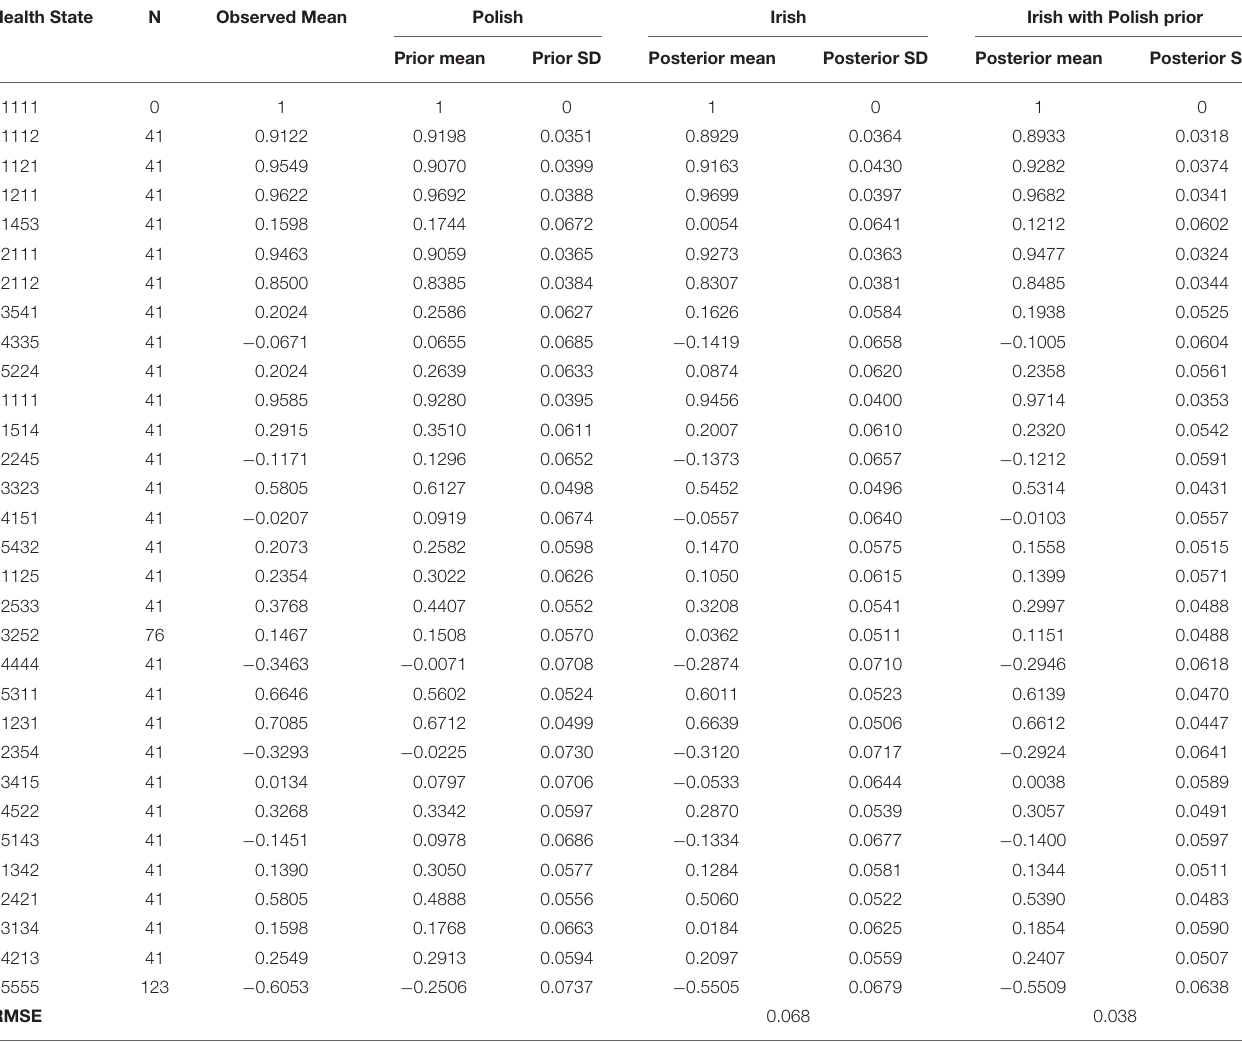
TABLE 1 | Estimates for utilities of the 30 EQ-5D-5L health states valued in the survey in addition to the full health. Health